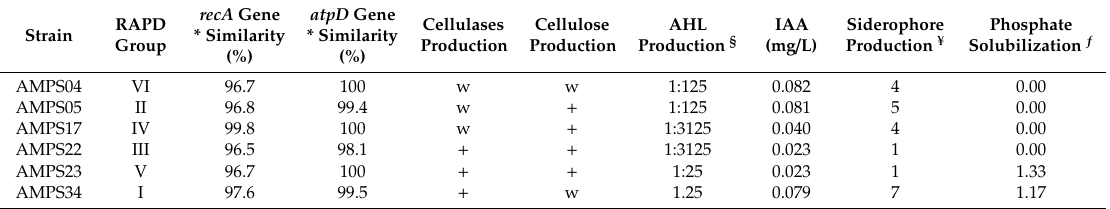
Table 1. Characteristics of selected strains isolated from Pisum sativum root